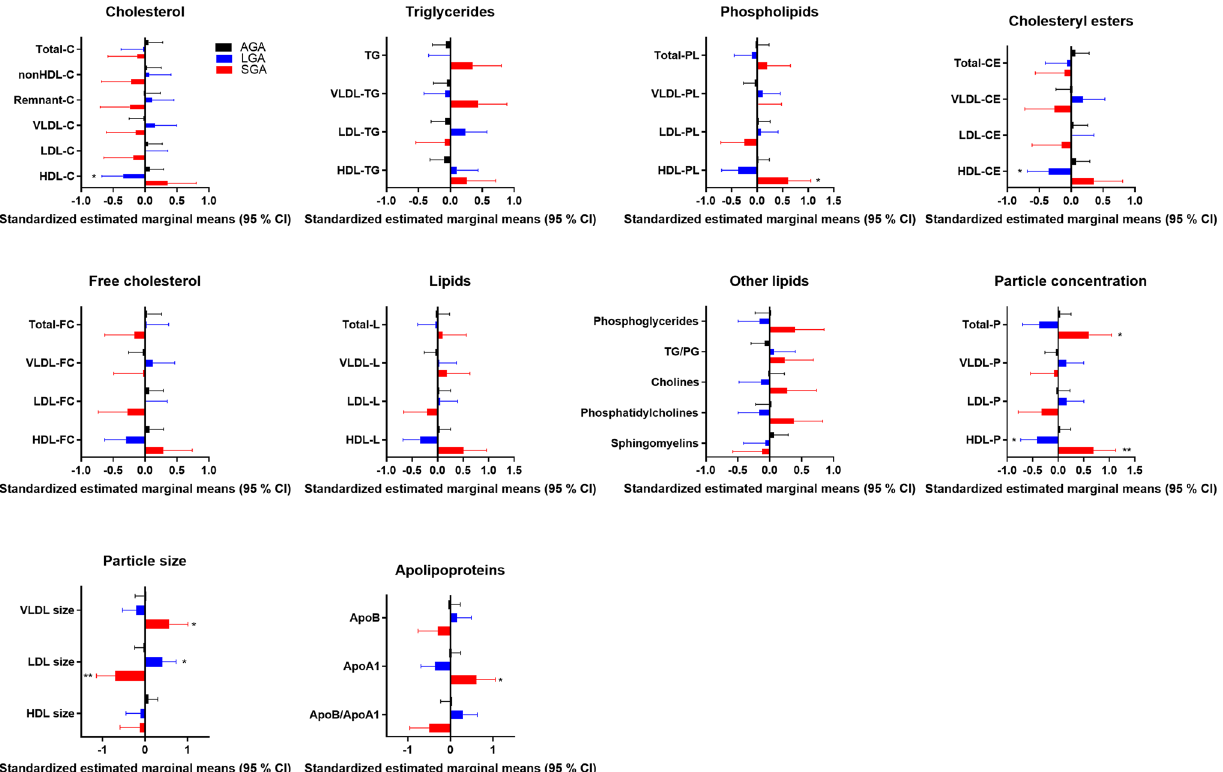
infants. Data is normalized and given as standardized estimated marginal means and 95 confidence interval adjusted for age, fetal sex, gestational diabetes, preeclampsia and BMI at week 14–16. *p < 0.05, **p < 0.01, ***p <